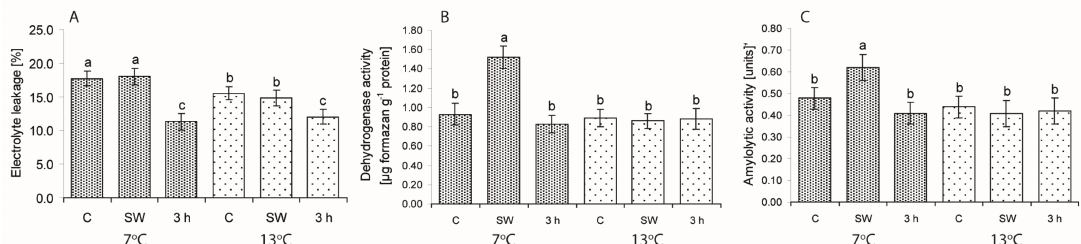
Figure 3. Effect of low (7 ◦ C) and control (13 ◦ C) temperatures and treatments on the percentage of ion leakage ( A ), dehydrogenase ( B ) and amylolytic activity ( C ) in the seeds of lines/cultivars included in Group I (weakly germinating). C—control, non-stimulated seeds; SW—smoke water; 3 h—3-h hydropriming. Values represent means ± SE of four lines/cultivars based on five replicates in the case of DA and A, and on 10 replicates in the case of EL for each line/cultivar. Different superscript letters (a, b, c, ...) in the columns indicate significant differences between means (Duncan’s multiple range test; p < 0.05). One unit of amylolytic activity means a decrease in absorbance by 0.02 which released 0.1 mg of starch hydrolyzed in 10 min per 1 mg of protein.